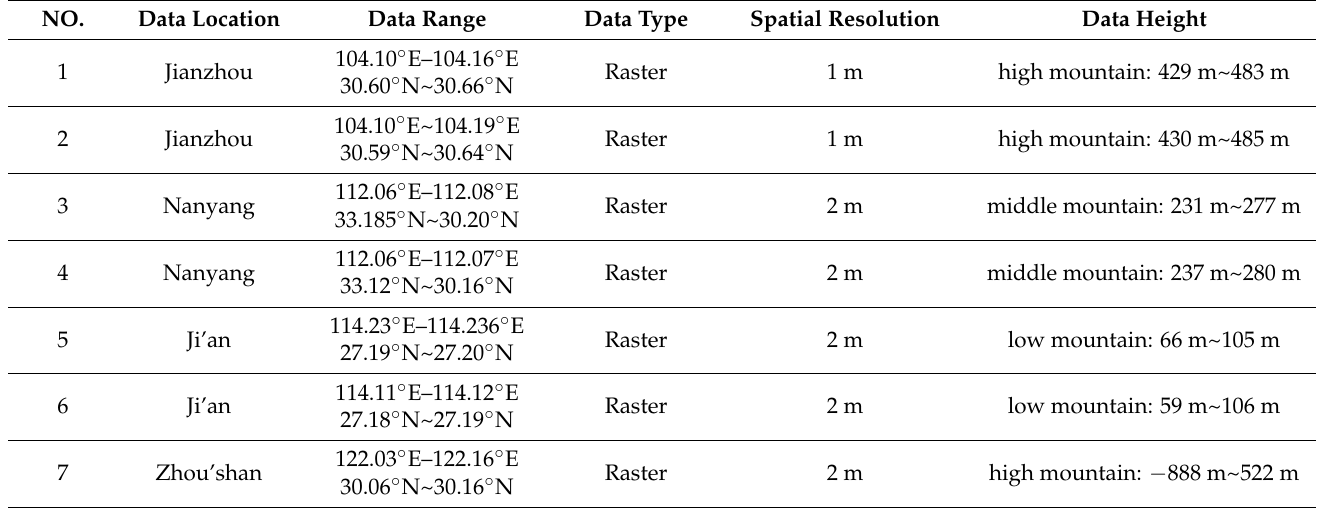
Table 3. The difference between the experimental